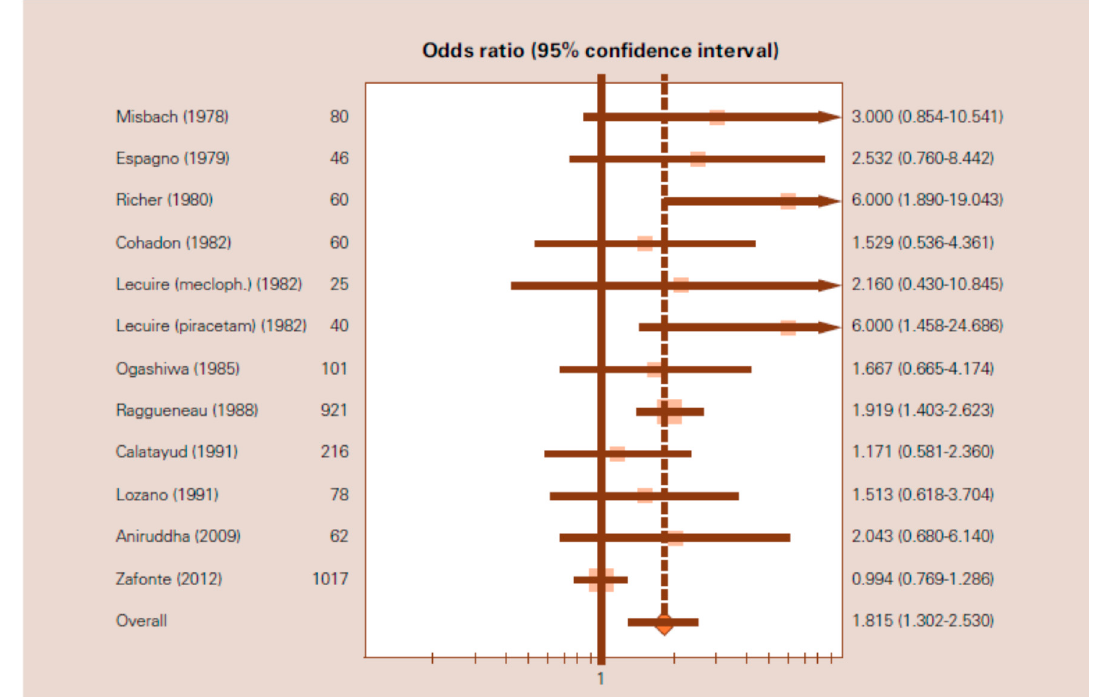
Figure 3. Forest plot of the meta-analysis of the effects of citicoline on independence after traumatic brain injury. OR = 1.815 (95% CI:1.302–2.530) based on the random-effects model. (From Secades, J.J. Citicoline for the Treatment of Head Injury: A Systematic Review and Meta-analysis of Controlled Clinical Trials. J. Trauma. Treat . 2014 , 4 , 227).